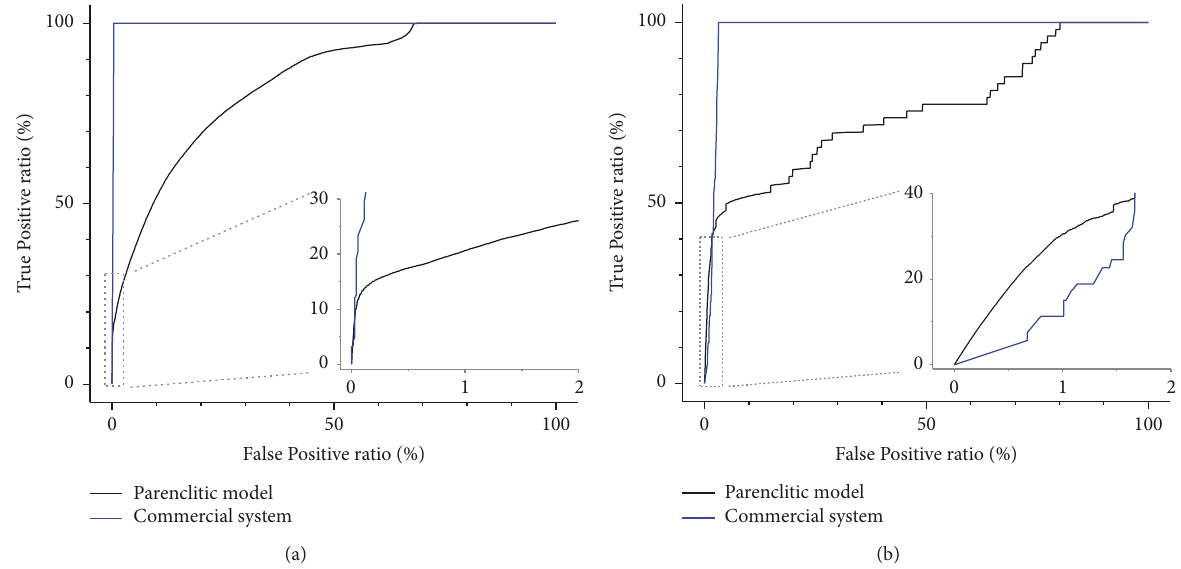
Figure 4: (a) ROC curves for the network-based model (black line) and a commercial system (blue line). (b) ROC curves, for the proposed network-based algorithm and a commercial system, when only on-line (Internet) transactions are